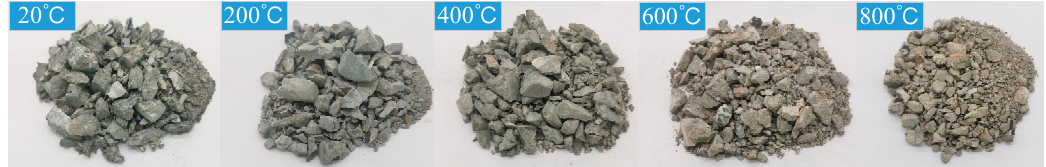
Figure 5. The crushing morphology of BFRC specimens after exposed to different temperatures.